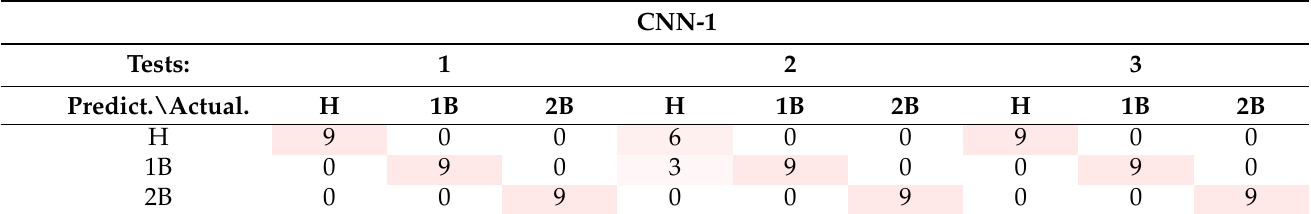
Table 7. Confusion matrix of the CNN-1 model with fault type classification.